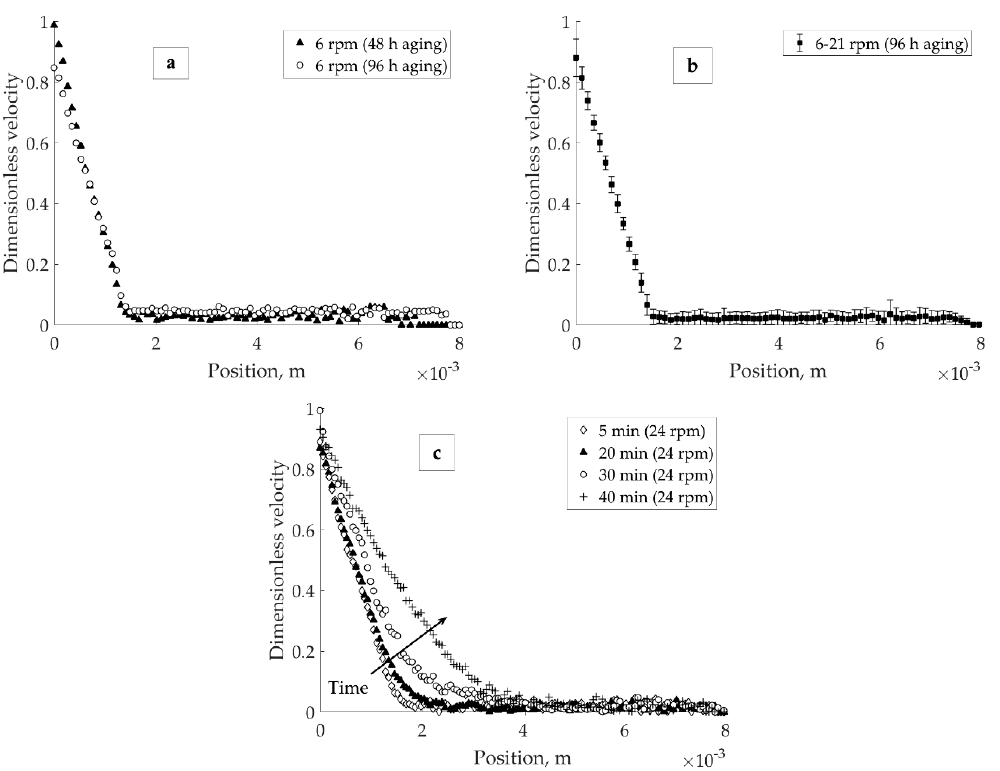
Figure 5. Dimensionless velocity profiles for pH 4 in 1 × 10 − 2 M KNO 3 sample: ( a ) Comparison of velocity profiles after 48 and 96 h of aging, 6 rpm; ( b ) After 96 h of aging, the average of 14 profiles collected at 6, 9, 12, 15, 18, and 21 rpm during 2.5 h; ( c ) Achievement of a steady localized profile after loss of banding, 24 rpm.